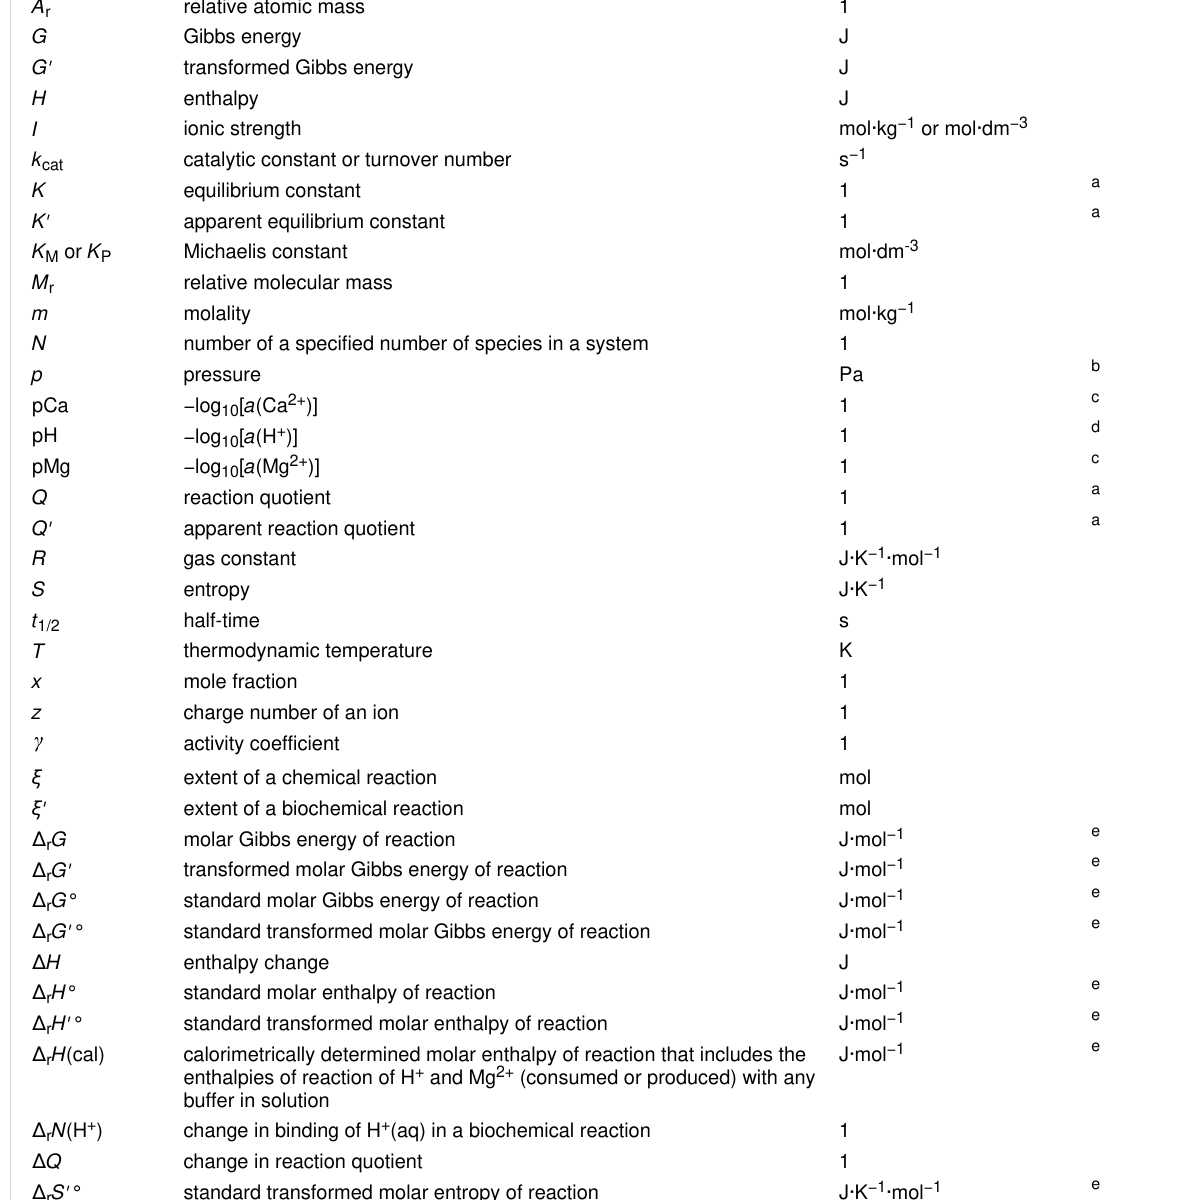
A r relative atomic mass